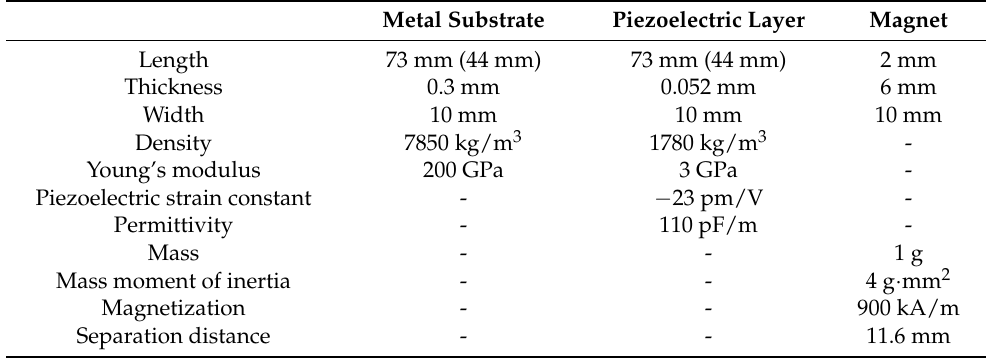
Table 1. Geometric dimensions and material properties of the 2-DOF MCBEH. The values in the parentheses are the values for beam 2. Metal Substrate Piezoelectric Layer Magnet Length 73 mm (44 mm) 73 mm (44 mm) 2 mm Thickness 0.3 mm 0.052 mm 6 mm Width 10 mm 10 mm 10 mm Density 7850 kg/m 3 1780 kg/m 3 - Young’s modulus 200 GPa 3 GPa - Piezoelectric strain constant - − 23 pm/V - Permittivity - 110 pF/m - Mass - - 1 g Mass moment of inertia - - 4 g · mm 2 Magnetization - - 900 kA/m Separation distance - - 11.6